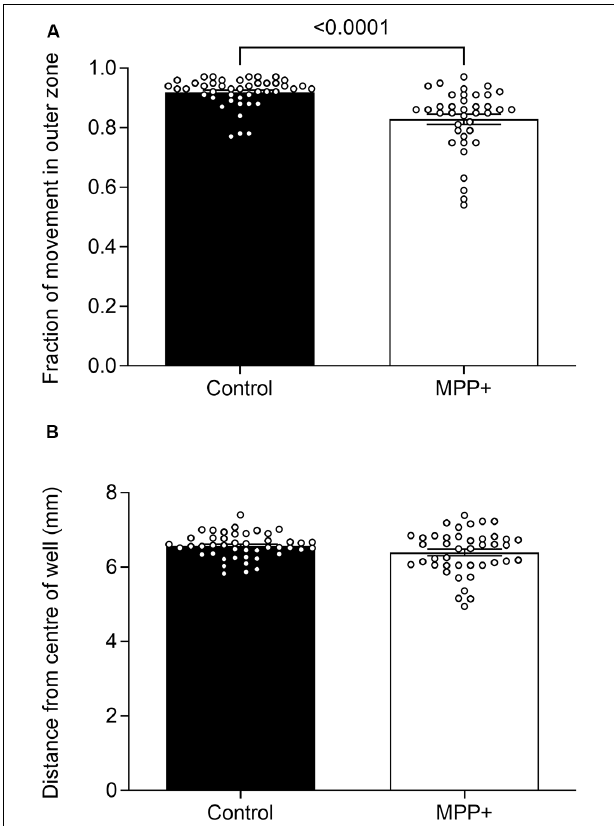
FIGURE 4 | Effects of MPP+ on thigmotaxis. Thigmotaxis was evaluated at 6 dpf in the absence (Control) or presence of 500 µ M MPP+ and represented as (A) the fraction of total distance swum in the outer zone of the well and (B) the average distance from the center of the well during lights-on. Data are represented as means ± SEM from four independent experiments pooled, control group n = 45, MPP+ group n = 42. Normality was tested using D’Agostino and Pearson omnibus normality test followed by a two-tailed unpaired t -test or two-tailed Mann–Whitney U